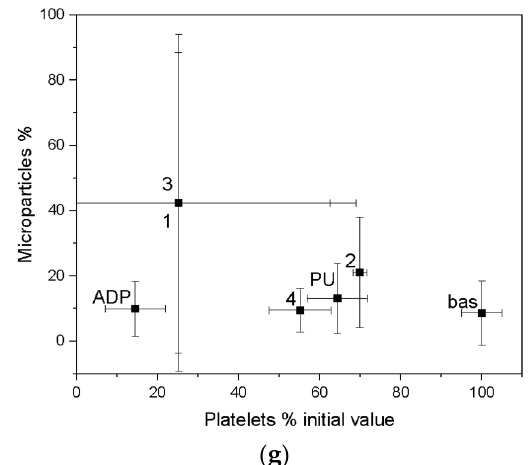
Figure 10. Blood–material interaction in the dynamic conditions. Bas—negative control, PU—refer- ence substrate-medically used polyurethane, ADP—activated blood-positive control: ( a ) Activation of P-selectin receptor caused by direct contact with material under high shear condition; ( b ) Activa- tion of platelet IIb/IIIa receptor caused by direct contact with the tested material under high shear condition; ( c ) All platelet aggregate caused by direct contact with material under high shear stress; ( d ) Small platelet aggregate caused by direct contact with material under high shear stress; ( e ) Large platelet aggregate caused by direct contact with material under high shear stress; ( f ) Platelet-mono- cyte aggregates created by direct contact with material under high shear condition; ( g ) Platelet-de- rived microparticles created by direct contact with artificial surface under shear stress condition.